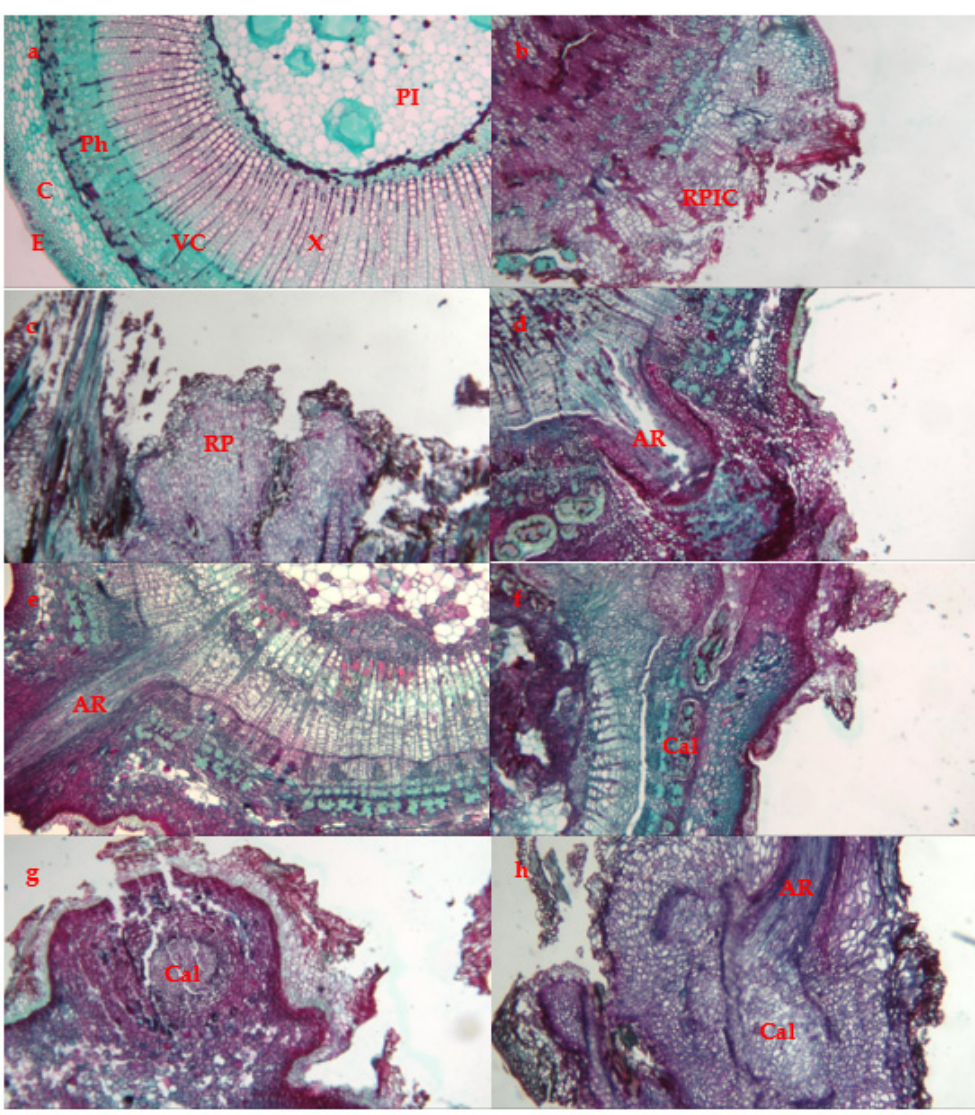
Figure 3. Anatomical properties of adventitious root development in the cutting bases from 7-year- old ortets. ( a ) Transverse sections of cutting bases before cultivation; ( b ) Root primordium initial cells were formed in vascular cambium at the 10th day in cultivation; ( c ) Root primordia were formed in vascular cambium at the 20th day in cultivation; ( d ) Adventitious roots were formed in vascular cambium at the 30th day in cultivation; ( e ) Adventitious root elongation from vascular cambium at the 40th day in cultivation; ( f ) Calluses were formed on the inner of cutting bases at the 20th day in cultivation; ( g ) Calluses were formed on the surface of cutting bases at the 20th day in cultivation; ( h ) Adventitious roots were formed in calluses of cutting bases at the 40th day in cultivation